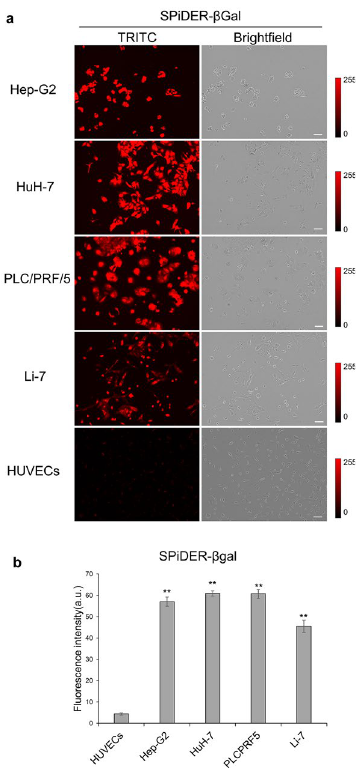
Figure 2. Fluorescence imaging of live cells. ( a ) Fluorescence live cell imaging of hepatocellular carcinoma (HCC) cell lines (Hep-G2, HuH-7, PLC/PRF/5, and Li-7) and HUVECs using SPiDER-βGal (1 μM). Fluorescence was determined using a TRITC filter (left) and Brightfield images (right); images were captured using a Keyence BZ-X800 with a TRITC filter (Excitation: 545/25 nm, Emission: 605/70 nm, Exposure time: 2 s). Scale bar = 100 μm. ( b ) The average fluorescence intensity of 10 randomly selected live cells imaged with SPiDER-βGal was determined using ImageJ (n = 10). Fluorescence intensity was significantly higher in HCC cell lines than in HUVECs (** p < 0.01). A two-tailed Mann–Whitney U -test was used. Error bars represent standard error (SE)